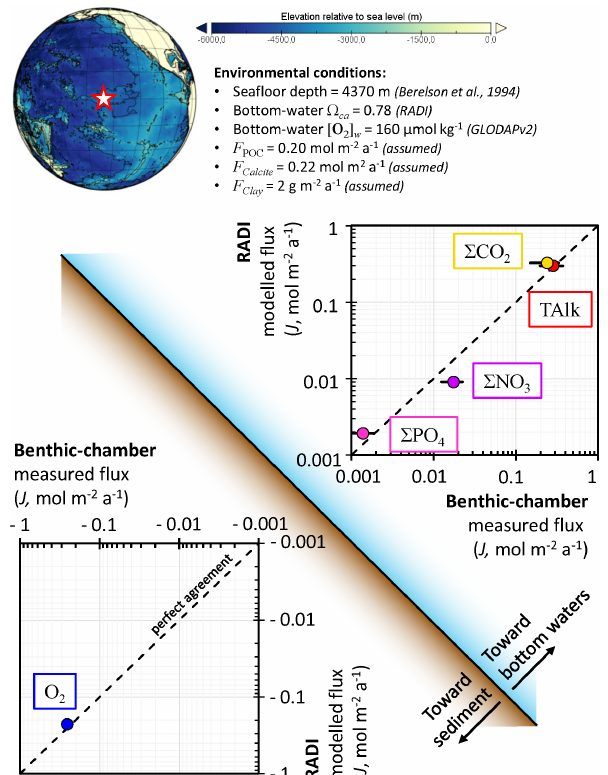
Figure 6. Comparison of fluxes computed from RADI with benthic- chamber measurements from the station no. W-2 described in Ham- mond et al. (1996). Error bars are included for all measured fluxes but are not always